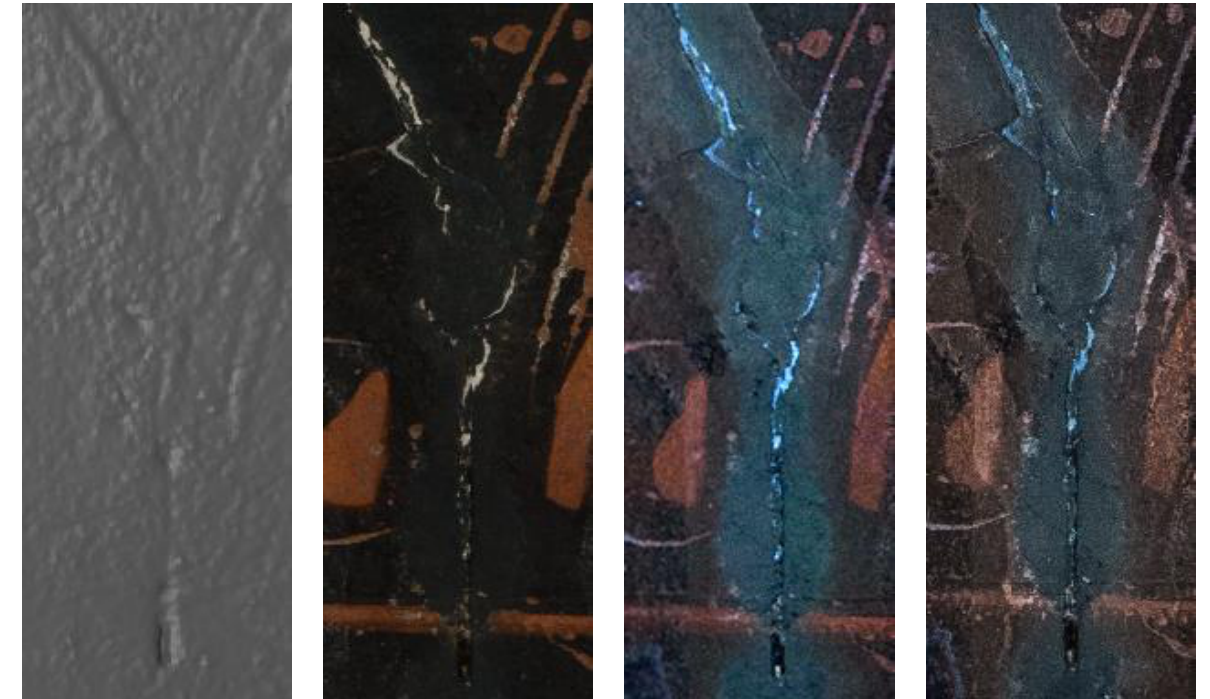
Figure 7. Detailed views of a break from the mesh model showing the geometry (a) and the three different texture mapping: VIS (b), UVL @ 254 nm (c), UVL @ 366 nm